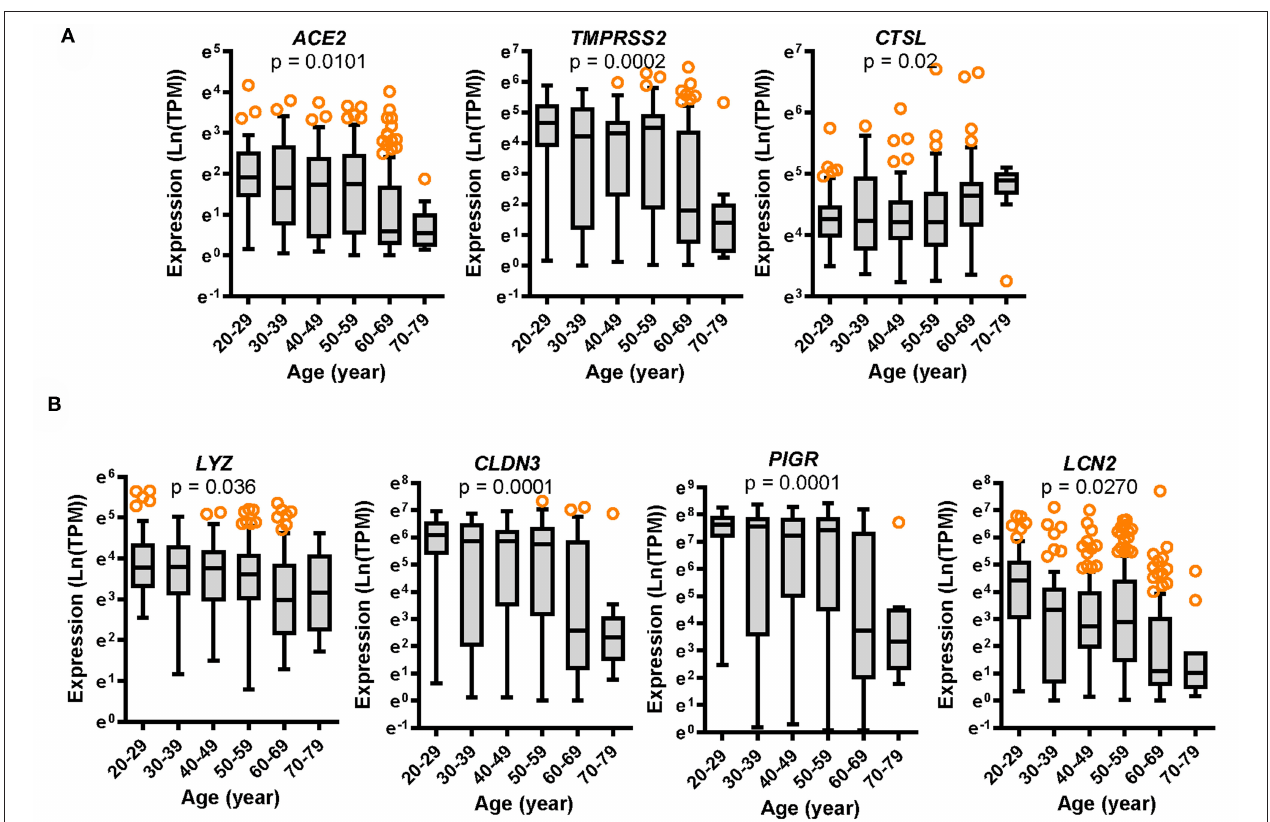
FIGURE 1 | Expression of SARS-CoV-2 receptors and gut defense biomarkers with age. Results are depicted as box-and-whisker plots (Turkey) for the expression of SARS-CoV-2 receptors ACE2, TMPRSS2 , and CTSL (A) or gut defense makers LYZ, CLDN3, PIGR , and LCN2 (B) in normal mucosal intestinal tissues (GTEx dataset v8). Values are presented as natural logarithm of transcripts per million (TPM). Statistical significance of the expression variation with age is illustrated on the top of each plot (Kruskal–Wallis